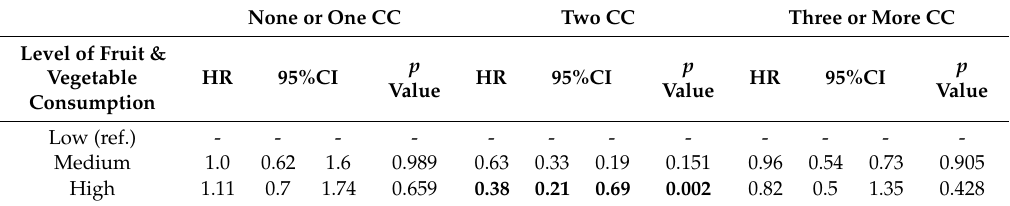
Table 3. Adjusted hazard ratios of the e ff ect of fruit and vegetable consumption by number of chronic conditions on all-cause mortality. Cox regression model ( n =